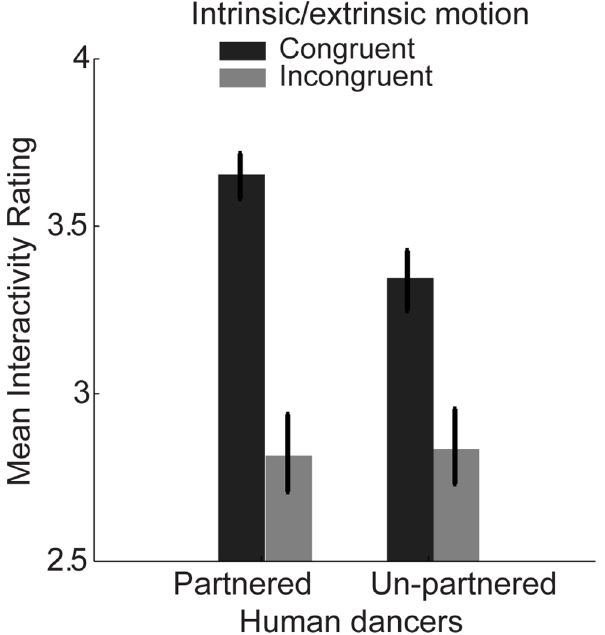
Figure 5. Mean group data from Experiment 3, showing mean interactivity ratings (on a five point scale; higher means more interactive) for spatially-scrambled salsa dancers. Salsa dancers were either paired with their true partner or a dancer chosen randomly from a different ‘‘snippet’’. Intrinsic/extrinsic motion congruency was manipulated by reversing the timecourse of extrinsic motion for each actor in the display, maintaining the overall coordination between the actors in terms intrinsic and extrinsic motion individually, but violating the consistency between these two sources of motion information. Error bars represent